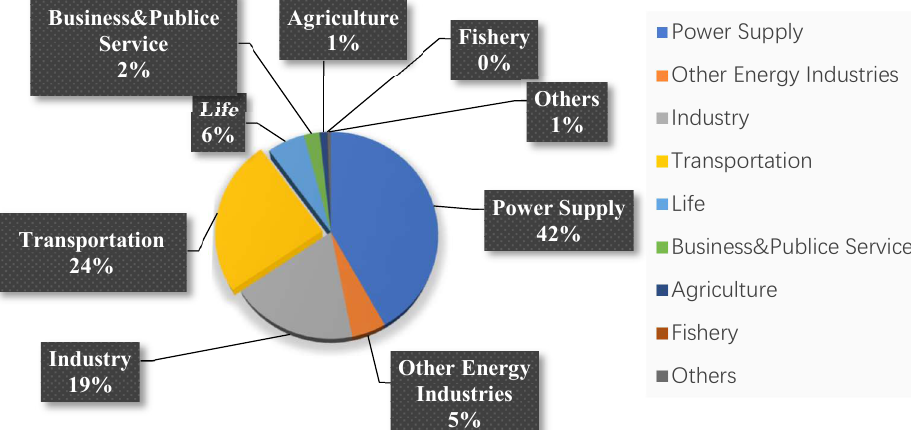
Figure 1. Proportions of global carbon emissions by sector in 2019.